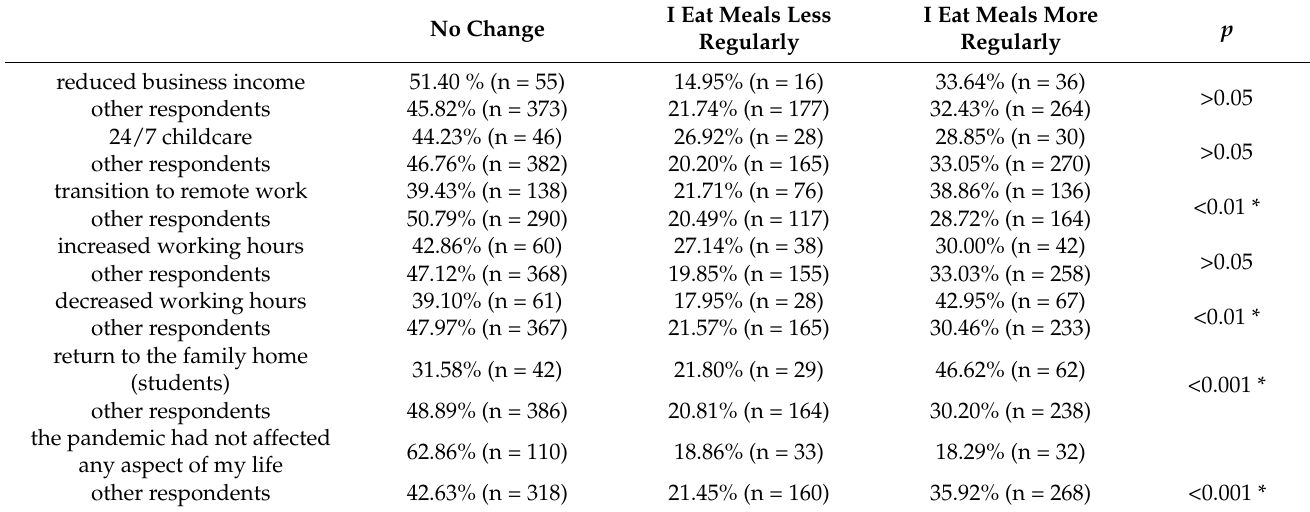
Table 3. Changes to meal consumption regularity acc. to life situation during the